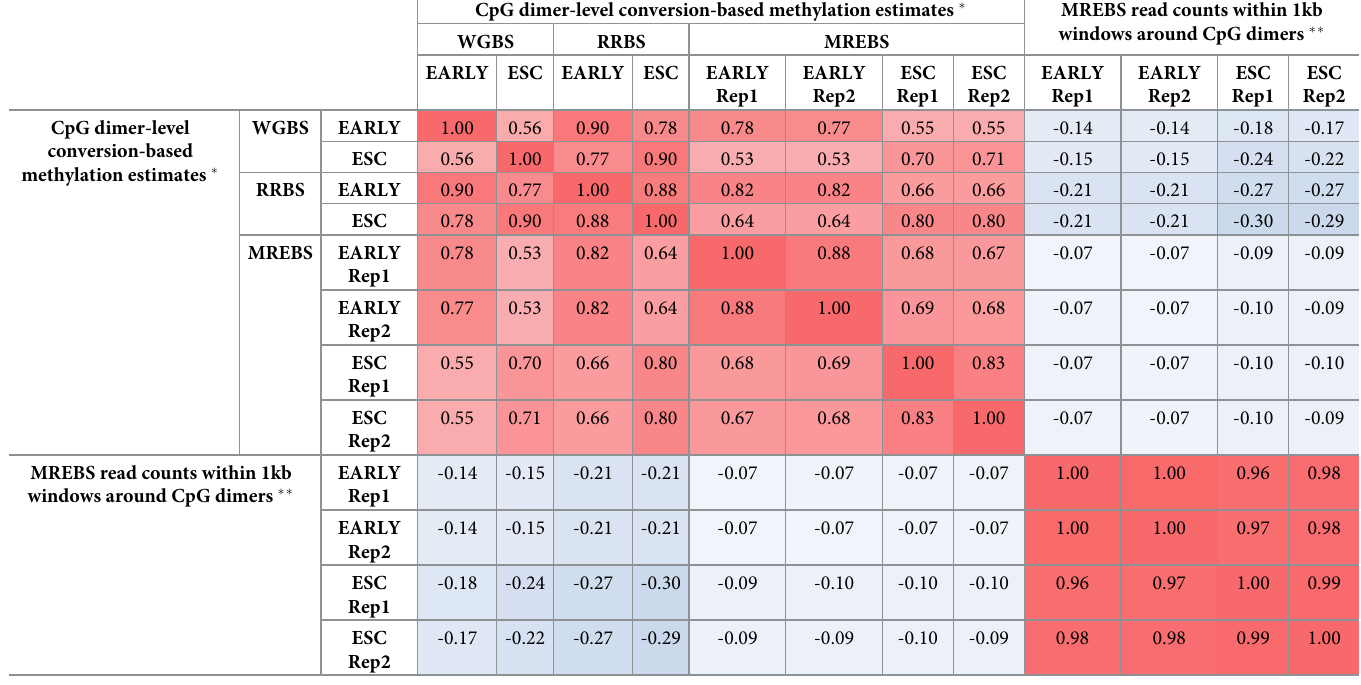
Table 1. CpG dimer-level correlations between bisulfite sequencing libraries. Pearson correlation values between WGBS, RRBS, and MREBS CpG dimer-level conver- sion-based methylation estimates, as well as binned read counts within 1kb windows around CpG dimers, for those with at least two MREBS reads. Red intensity signifies the strength of a positive correlation, while blue intensity signifies the strength of the anti-correlation.